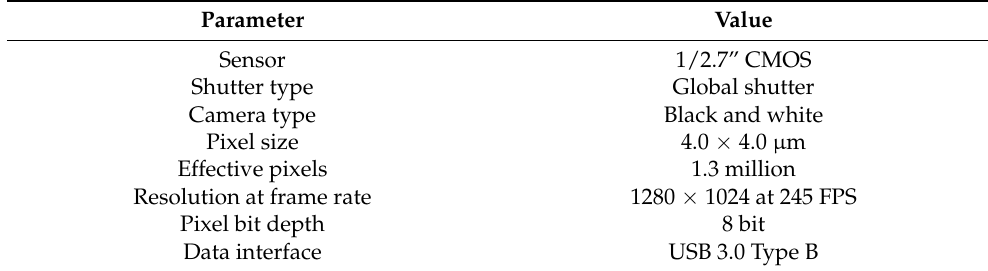
Table 1. The parameters of the